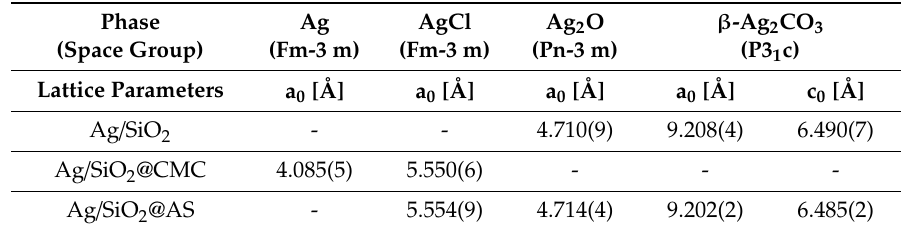
Table 1. The lattice parameters were determined from the XRD data and the analysis of the Rietveld refinement.